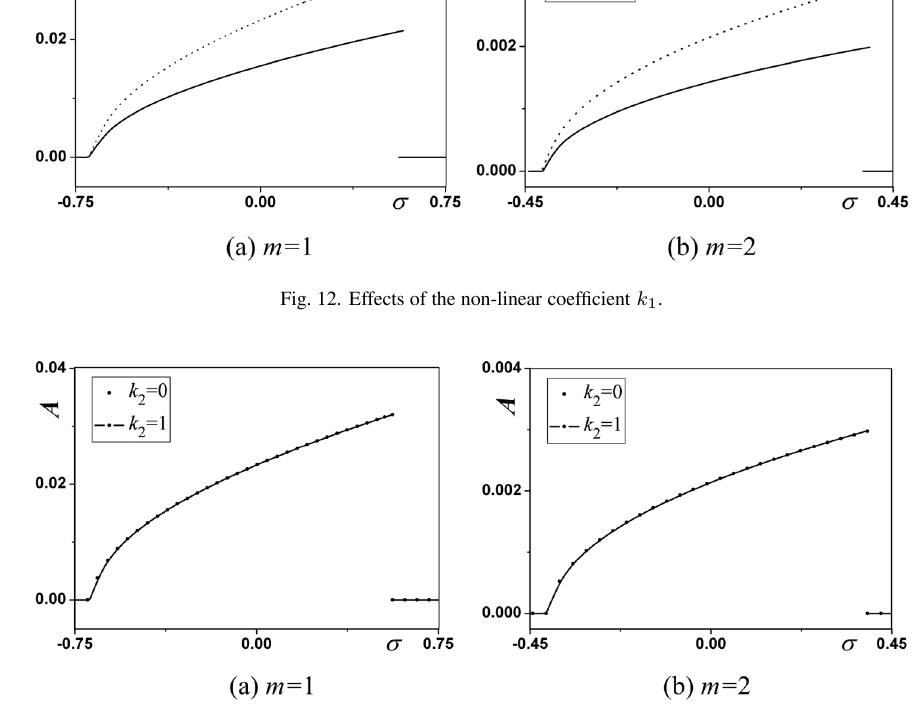
Fig. 13. Effects of the non-linear coef fi cient k 2